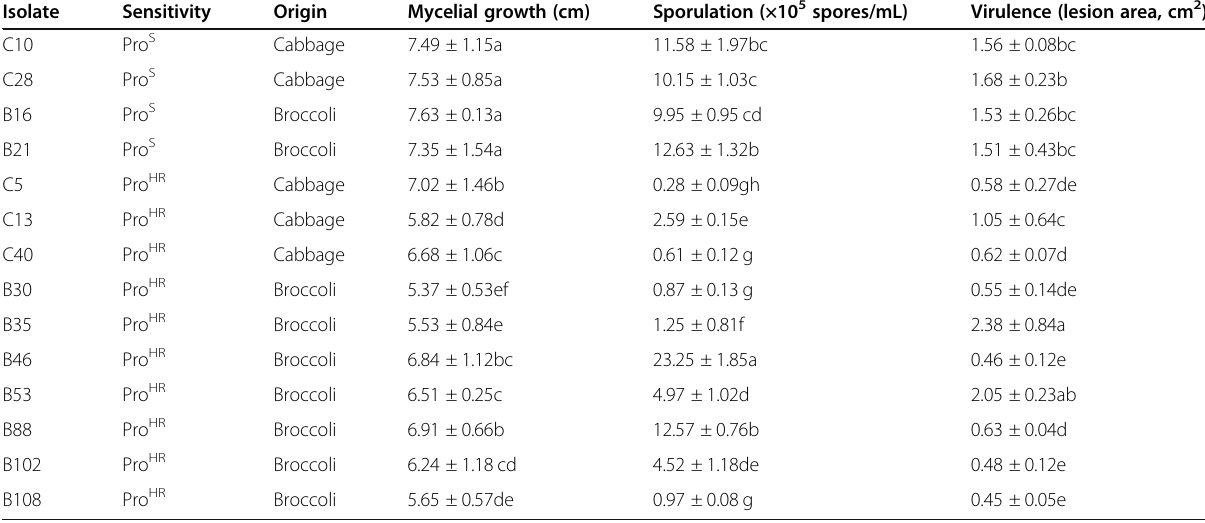
Table 3 Mycelial growth rate, sporulation and virulence in Pro S and Pro HR isolates of Alternaria alternata from cabbage and broccoli Isolate